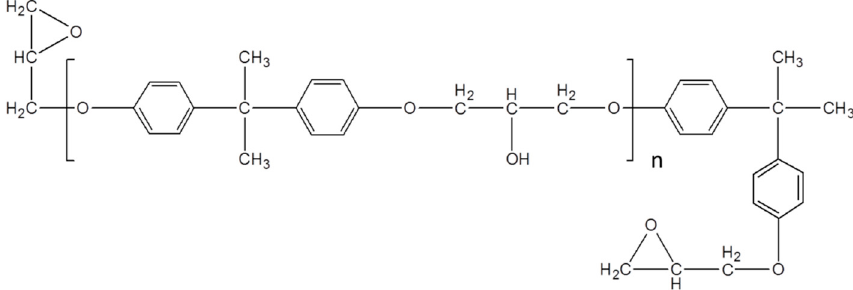
Figure 1. The molecular structure of the epoxy resin used in this paper.